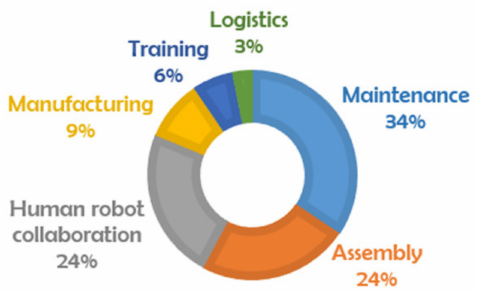
Figure 5. Areas of AR